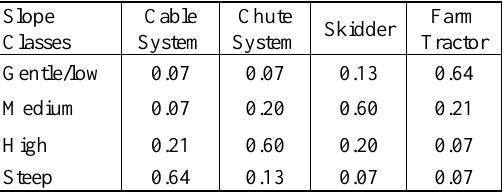
Table 5. The weighted values of slope class